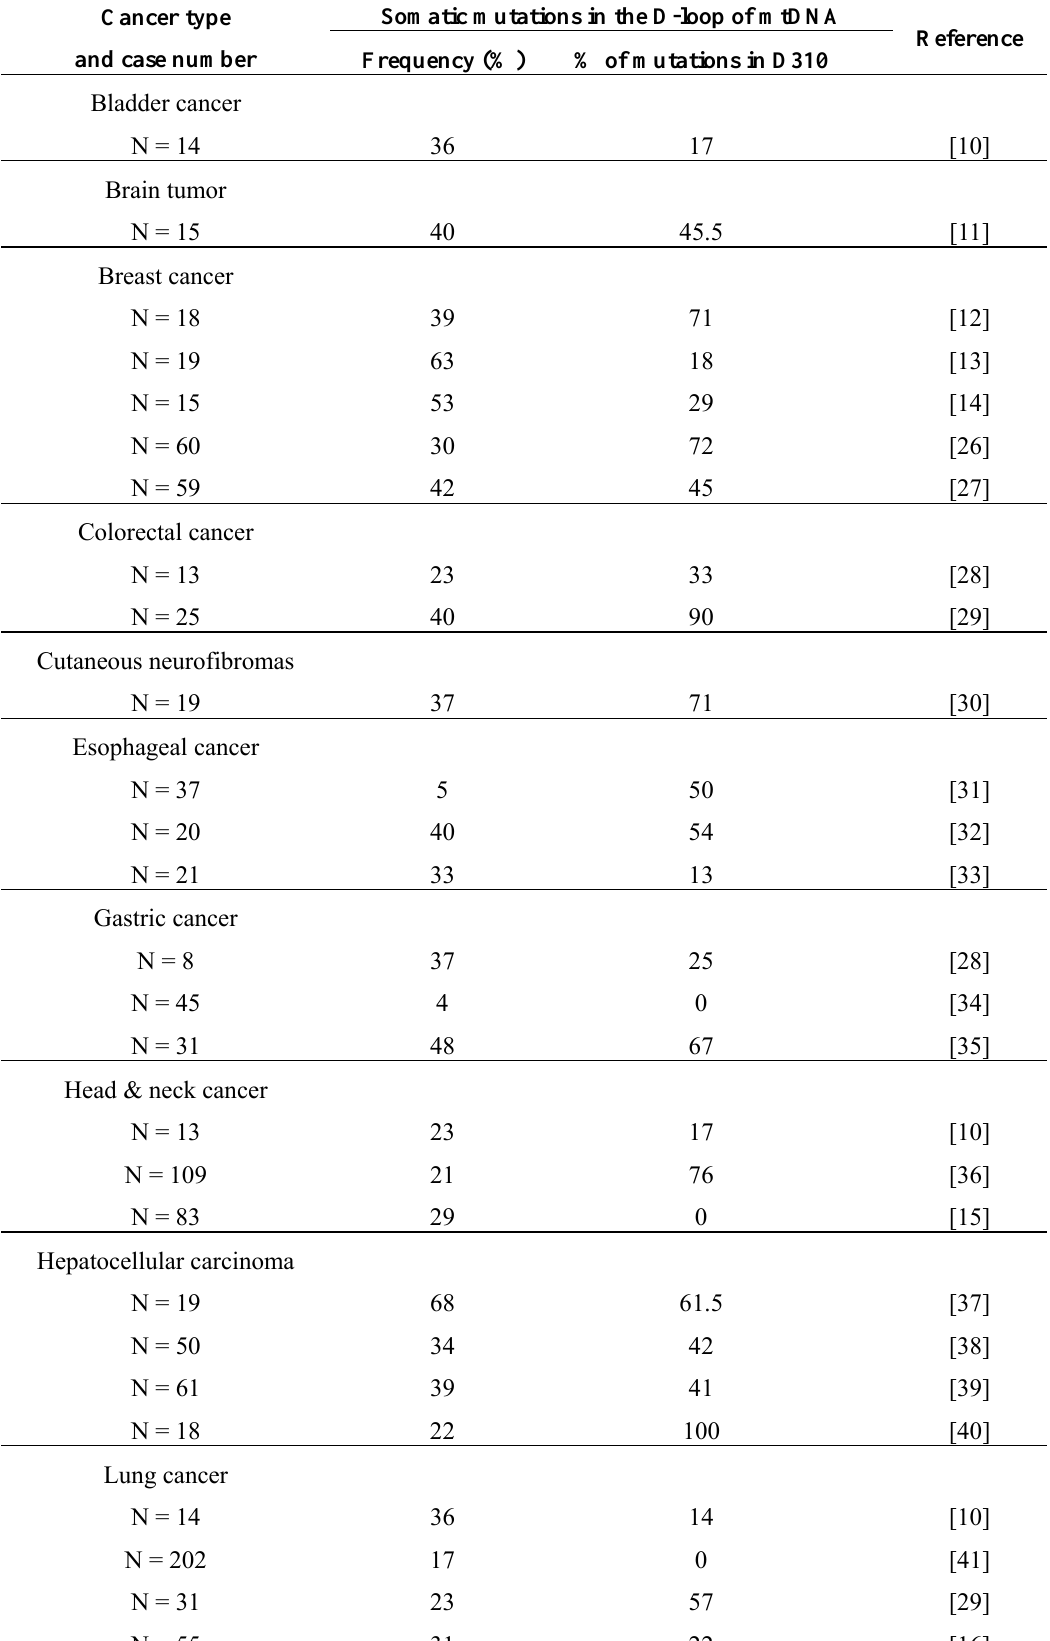
Table 2. Somatic mutations in the D-loop region of mtDNA of human cancers. Cancer